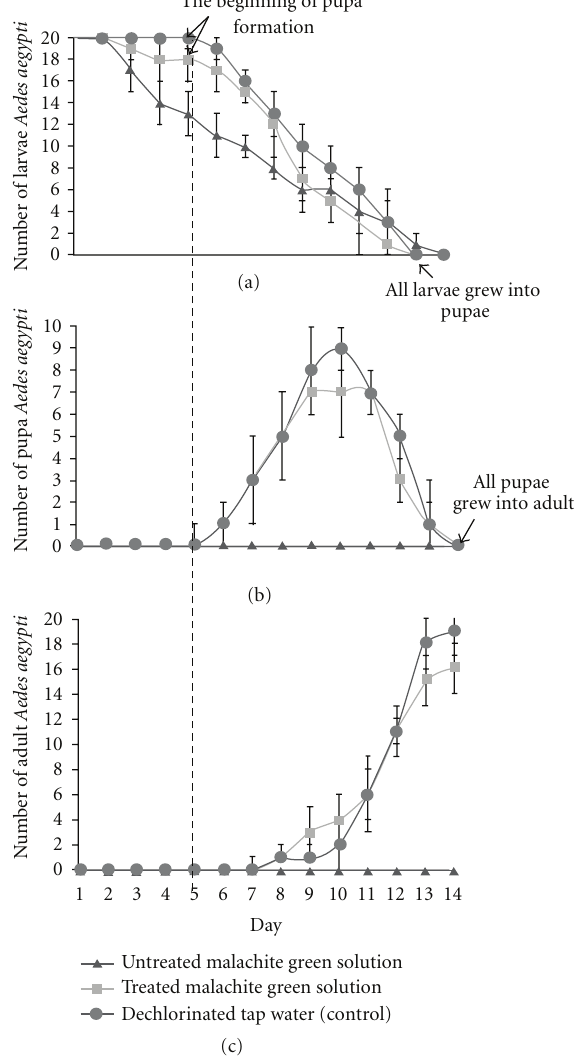
Figure 7: Survival trend of A. aegypti during stages of (a) larvae, (b) pupae, and (c) adult mosquito in untreated MG, treated MG solution, and control (dechlorinated tap water) over a period of 14 days.